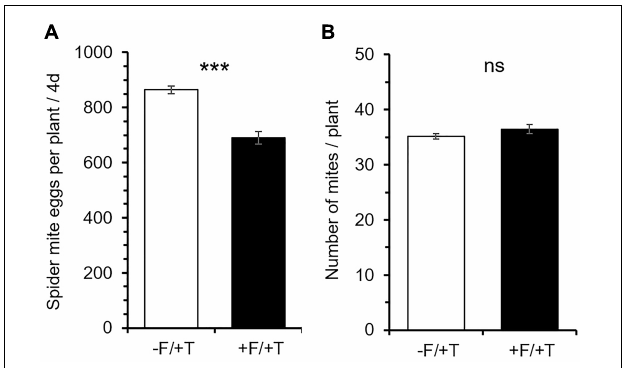
FIGURE 1 | Effects of tomato colonization by the endophyte Fusarium solani strain K (FsK) on spider mite ( Tetranychus urticae ) performance. One week after seed sowing plants were either inoculated with the endophyte (black bars, +F) or not (white bars, –F). Subsequently, plants were infested with 45 spider mites (15 mites per leaflet, 3 leaflets per plant, +T) when 4–5 weeks-old for a period of 4 days. Mean ± SE ( n = 13) of the (A) number of spider mite eggs per plant and (B) number of live adult females per plant recorded on FsK-colonized and control plants after 4 days. Significant differences between treatments are indicated by asterisks after Student’s t -test: ∗∗∗ P < 0.001, ns, not significant.